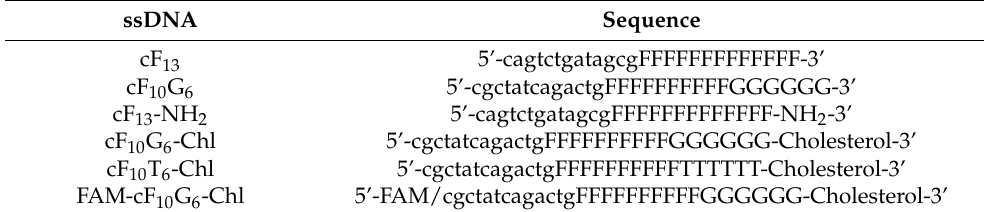
Table A1. Detailed information of the ssDNA